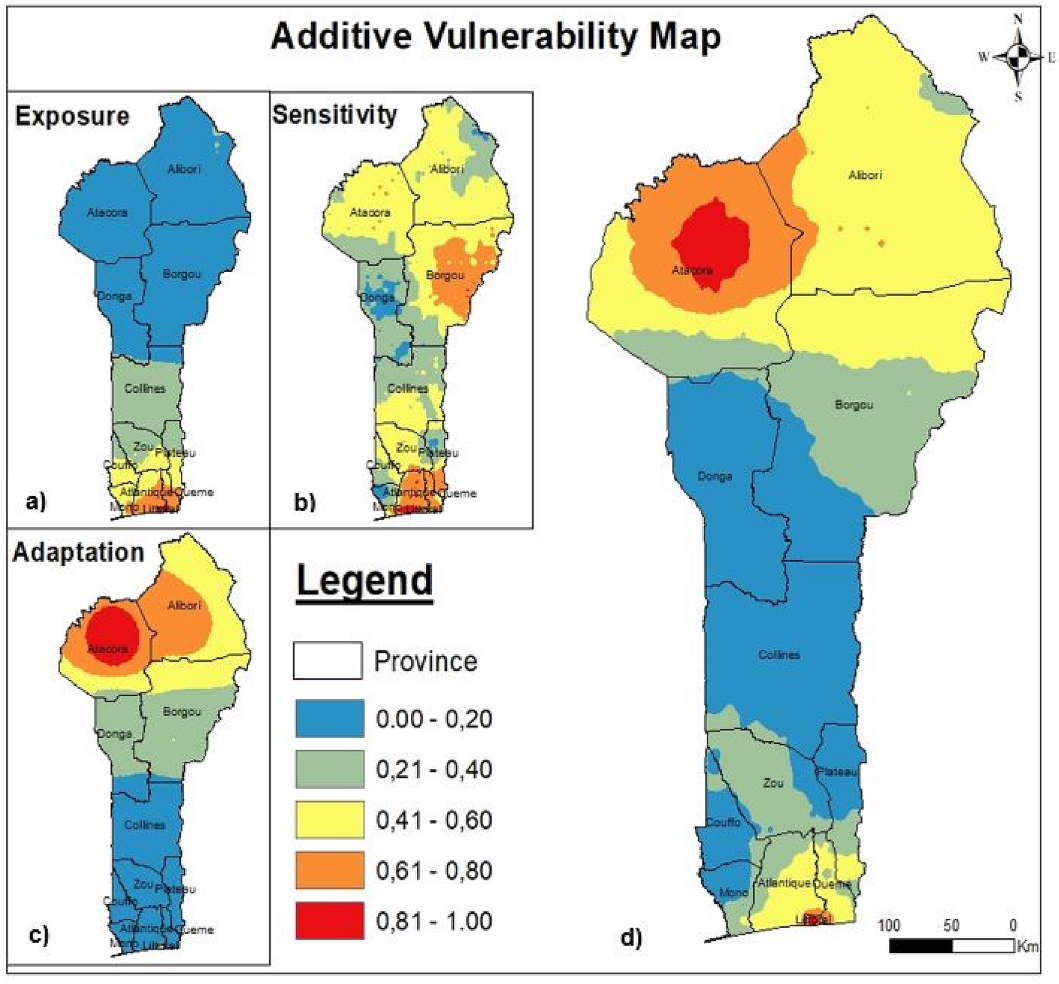
Figure 3. Additive vulnerability map.